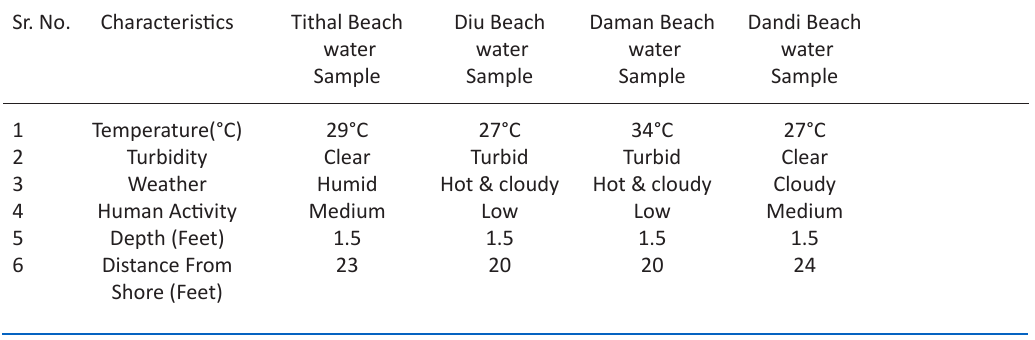
Table 1. Sampling conditions during collection of Arabian Sea water samples. Sr.